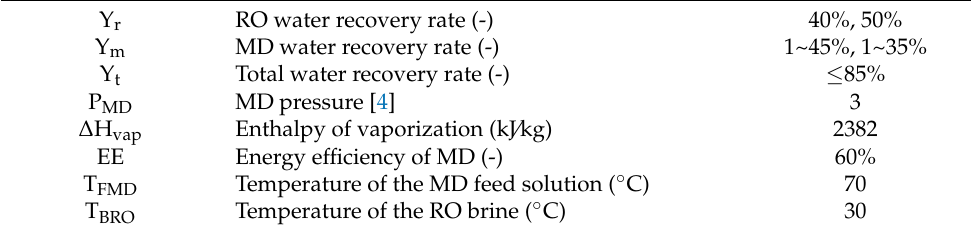
Table 2. Parameters for RO-MD process